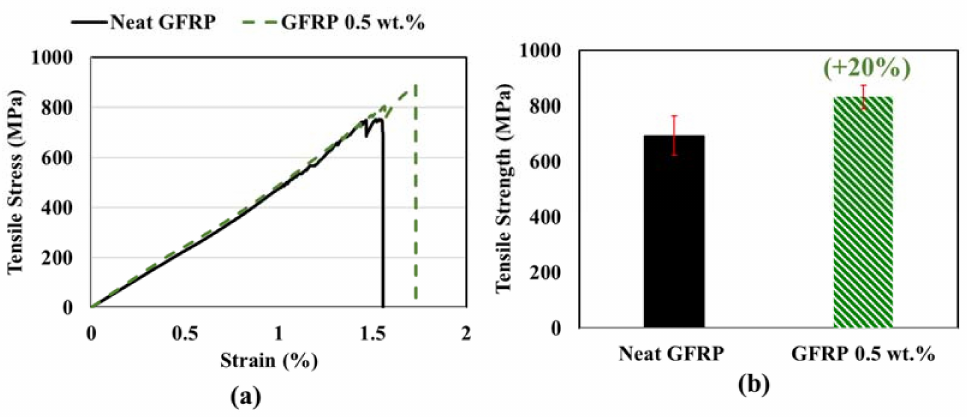
Figure 9. Longitudinal tension test: ( a ) representative stress–strain behavior; ( b ) comparison of the tensile strength of pultruded GFRP bars made with neat vinyl ester and 0.5 wt.% COOH-MWCNTs–vinyl ester nanocomposite. The percentage above the error bar shows the per percentage improvement compared with neat